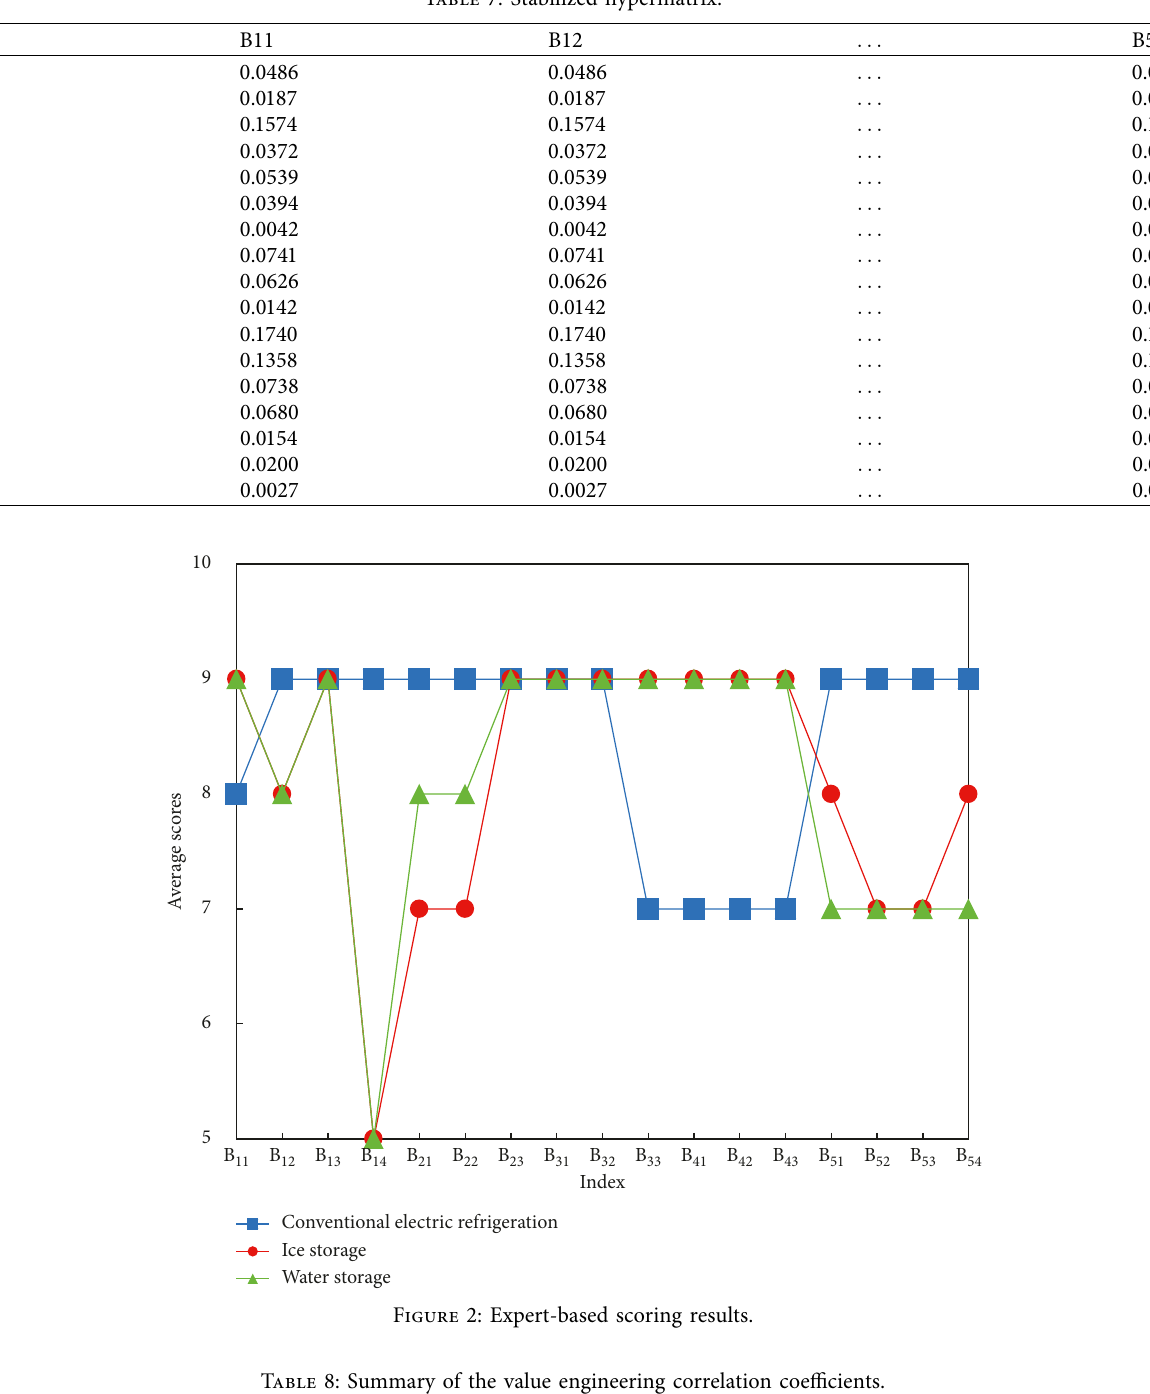
Table 7: Stabilized hypermatrix.